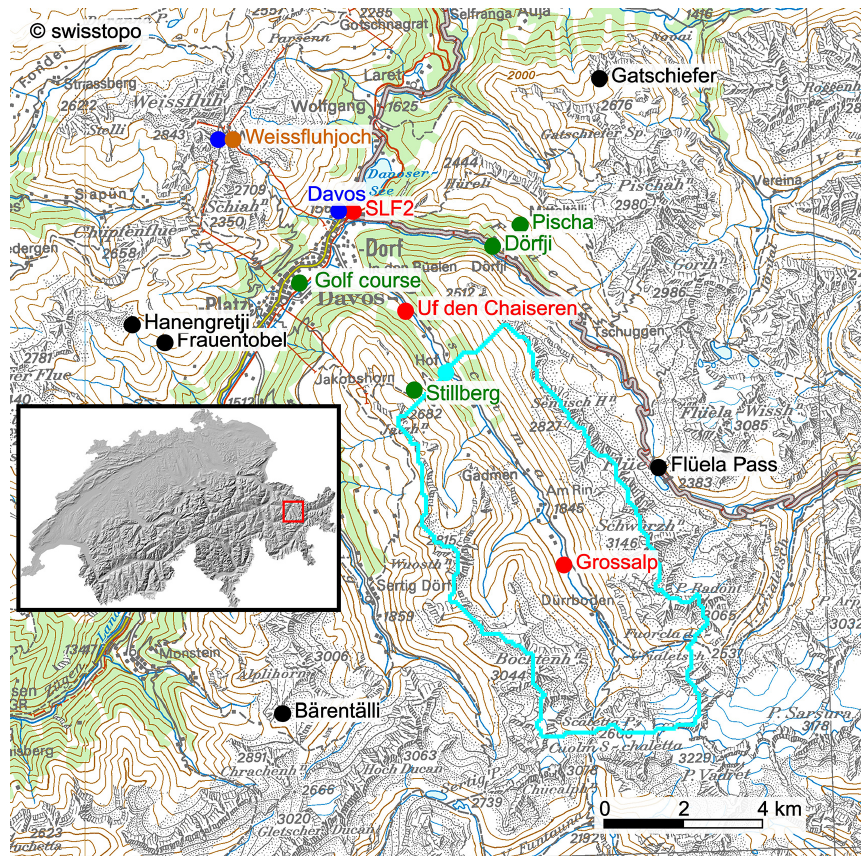
Figure 1. Topographical map of the simulated domain, showing the locations of the stations. Interkantonales Mess- und Informationssys- tem (IMIS) stations are shown in black, Interregionales Kriseninformationssystem (IRKIS) stations in red, SensorScope stations in green, SwissMetNet stations in blue and Weissfluhjoch in brown. The Dischma catchment and the gauging station measuring streamflow in the Dischmabach at the outlet of the Dischma catchment are shown in cyan. The inset shows the location of the simulation domain (red square) in Switzerland. Maps were reproduced by permission of swisstopo